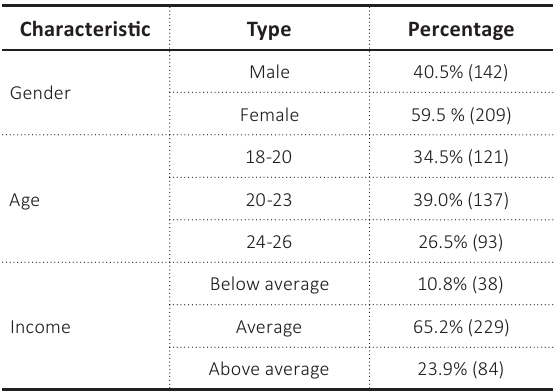
Table 1. Sample characteristics ( n =